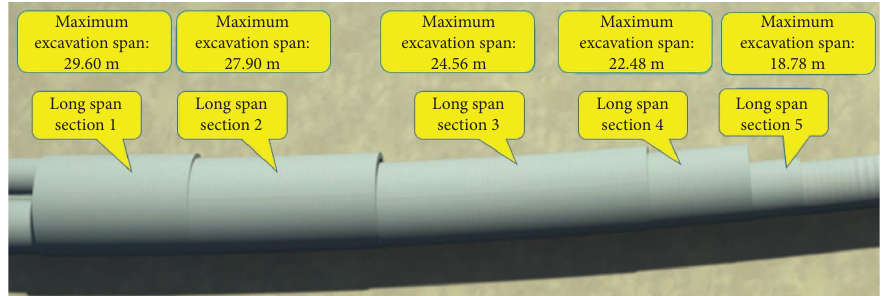
Figure 1: Rendering of large-span section of the Qizishan Tunnel.